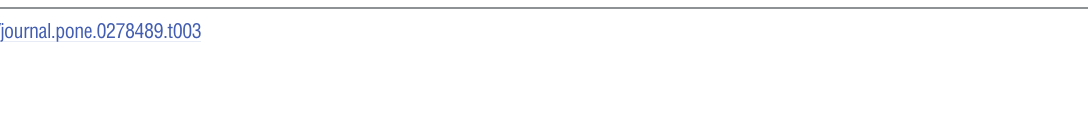
Table 3. Results of subgroup analysis about (DN) and incident depression.